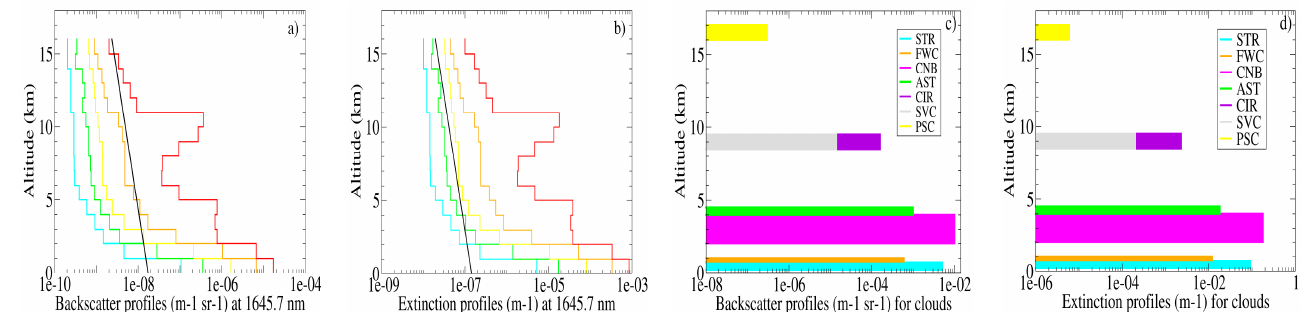
Figure 7. ( a ) Backscatter and ( b ) extinction profiles at 1645.7 nm prescribed from the ESA atmospheric reference model [25] for molecules (black curve) and aerosols (each curve comes from a climatological database of Atlantic aerosols [40]: lower decile value (LD) in blue, lower quartile (LQ) in green, median in yellow, upper quartile (HQ) in orange and upper decile (HD) in red). ( c ) Backscatter and ( d ) extinction profiles prescribed by the ESA atmospheric reference model [25] in the NIR-Visible region for different type of clouds: stratus, fair weather cumulus, cumulonimbus, altostratus, cirrus, sub-visible cirrus and polar stratospheric clouds.